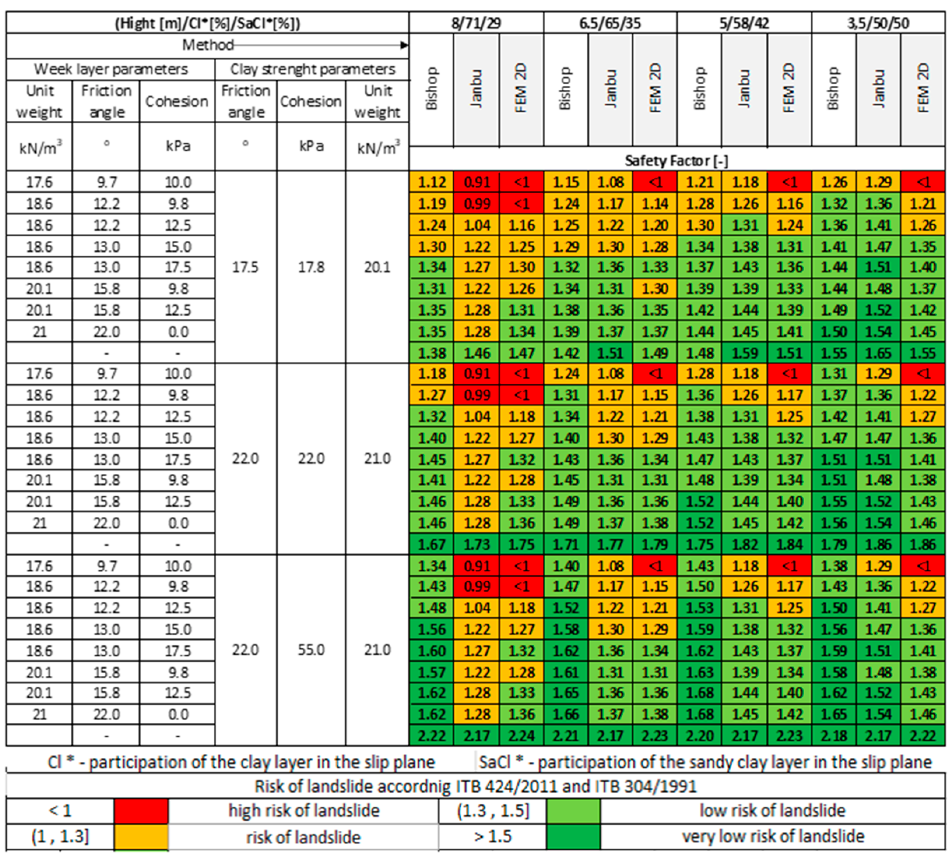
Figure 6. Results of stability modelling (plane strain analysis).